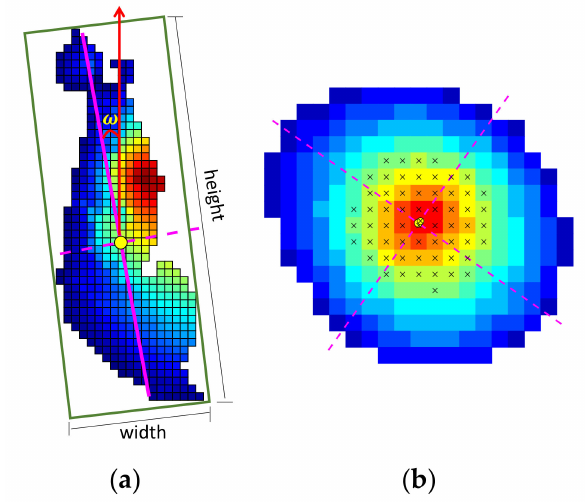
Figure 3. ( a ) An example demonstrating the function of the SPER toolbox for defining the spatial features of the ROI: the location presented by the yellow circle, the orientation (major axis) presented by the solid magenta line, while the minor axis is presented by the dashed line, the shape defined by its encompassing rectangle. ( b ) An example demonstrating the core (marked by × ) of the ROI detected by the algorithm of quantifying the hydroclimatic features of the SPER toolbox. The colour indicates the value of rainfall from relatively high (red) to low (blue) above the